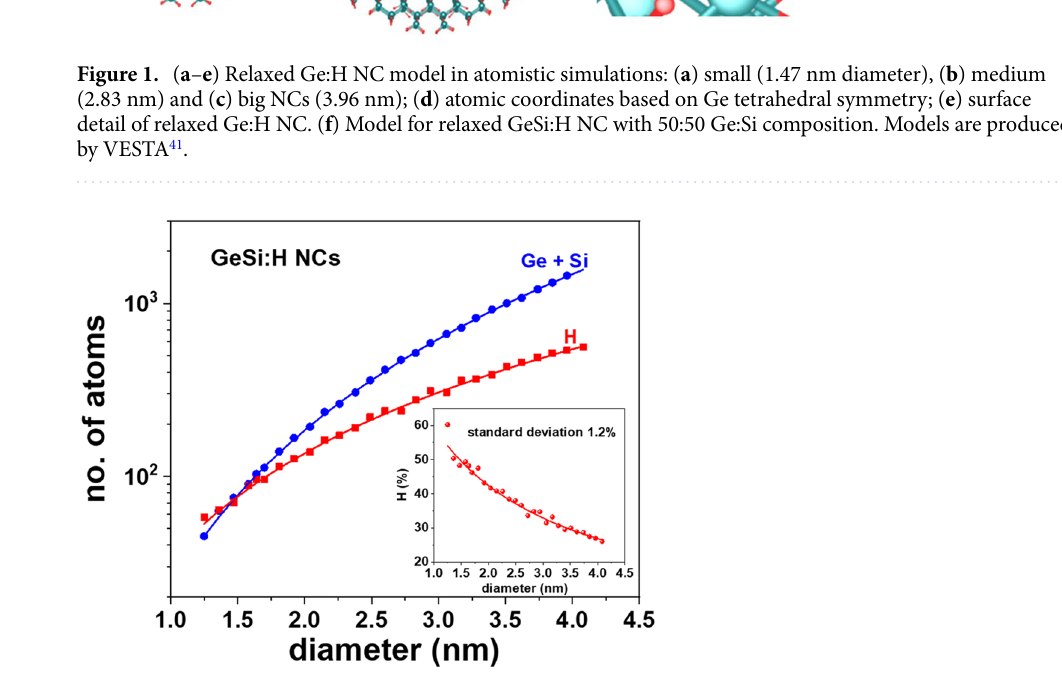
Figure 2. NC diameter dependences of the number of Ge and substituting Si atoms (blue dots), and the number of H atoms (red squares) necessary to construct the model of GeSi:H NCs with fully passivated surface; the continuous lines correspond to 44.0 atoms/nm 3 atomic density for Ge and Si and to 10.8 atoms/nm 2 for H surface density uniformly distributed on spherical GeSi:H NCs. The inset shows the concentration of H passivation atoms in